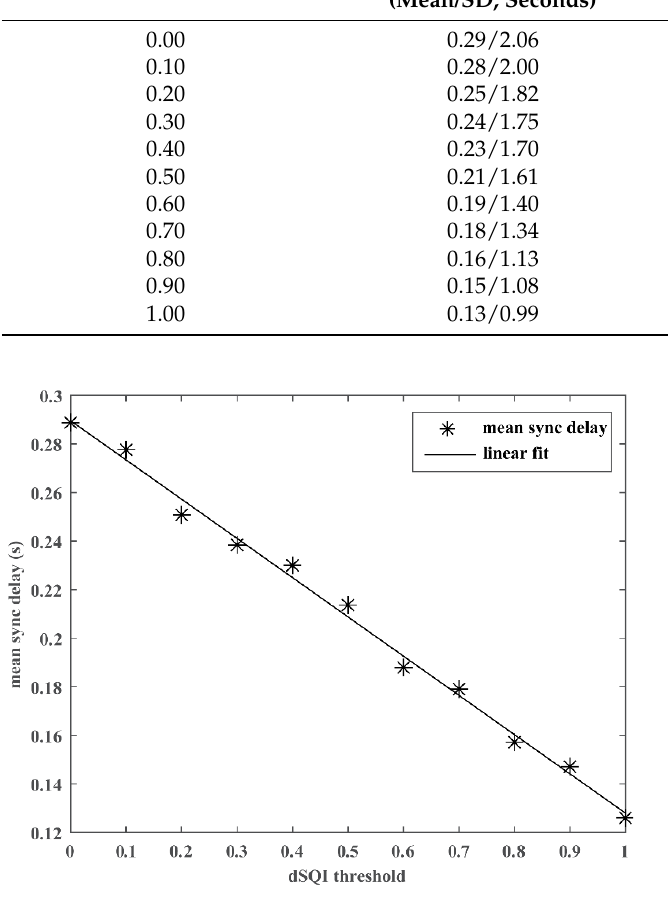
Figure 2. Correlation between dSQI thresholds and algorithm performance. Table 1. Time − synchronization algorithm performance with varying dSQI thresholding.